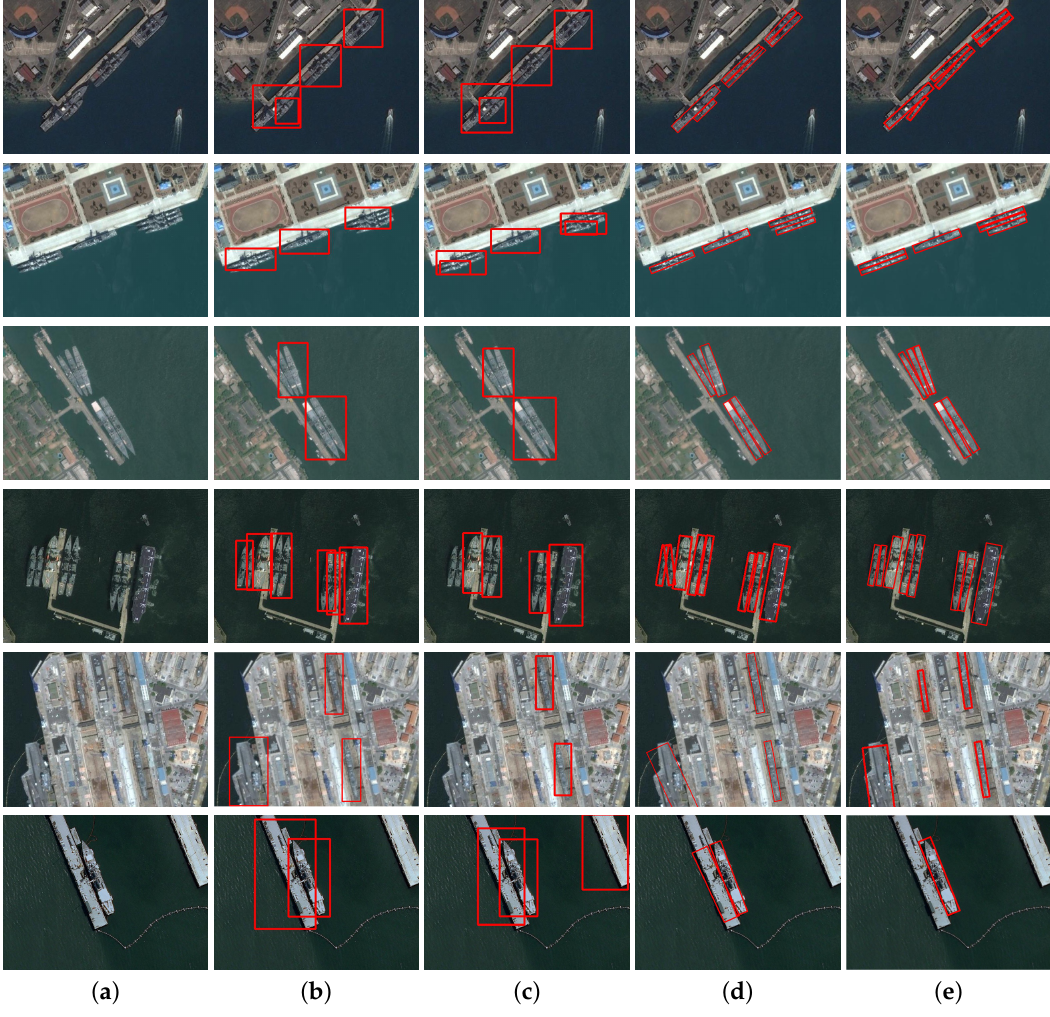
Figure 9. The ship-detection results from different methods. The images from the first row to the fourth row contain many closely docked ships. For the optical remote-sensing images in the last two rows, the backgrounds and the ship objects have very similar textures and appearances. Our method gives accurate detection results for all these cases. ( a ) Input; ( b ) Faster R-CNN [9]; ( c ) SSD [10]; ( d ) R-DFPN [16]; ( e )